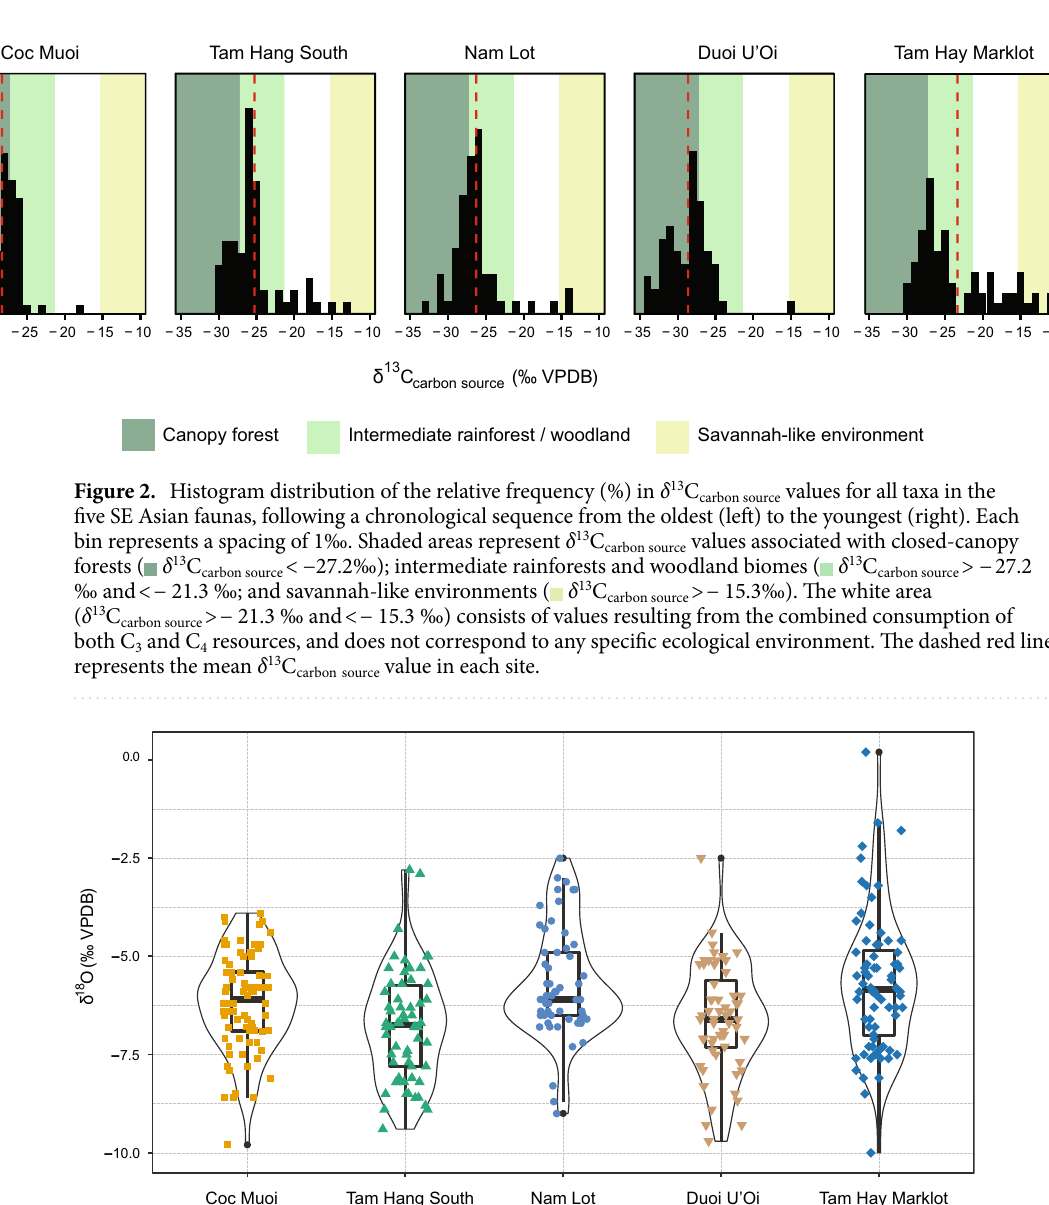
Figure 3. Distribution in δ 18 O values for all taxa in the five SE Asian faunas, following a chronological sequence from the oldest (left) to the youngest (right): Coc Muoi ( ), Tam Hang South ( ), Duoi U’Oi ( ) and previously published data from Nam Lot ( ) and Tam Hay Marklot ( ). The outline of the violin plots represents kernel probability density, where the width shows the proportion of the data found there. The boxes from the box and whisker plots inside the violin plots represent the 25th–75th percentiles, with the median as a bold horizontal